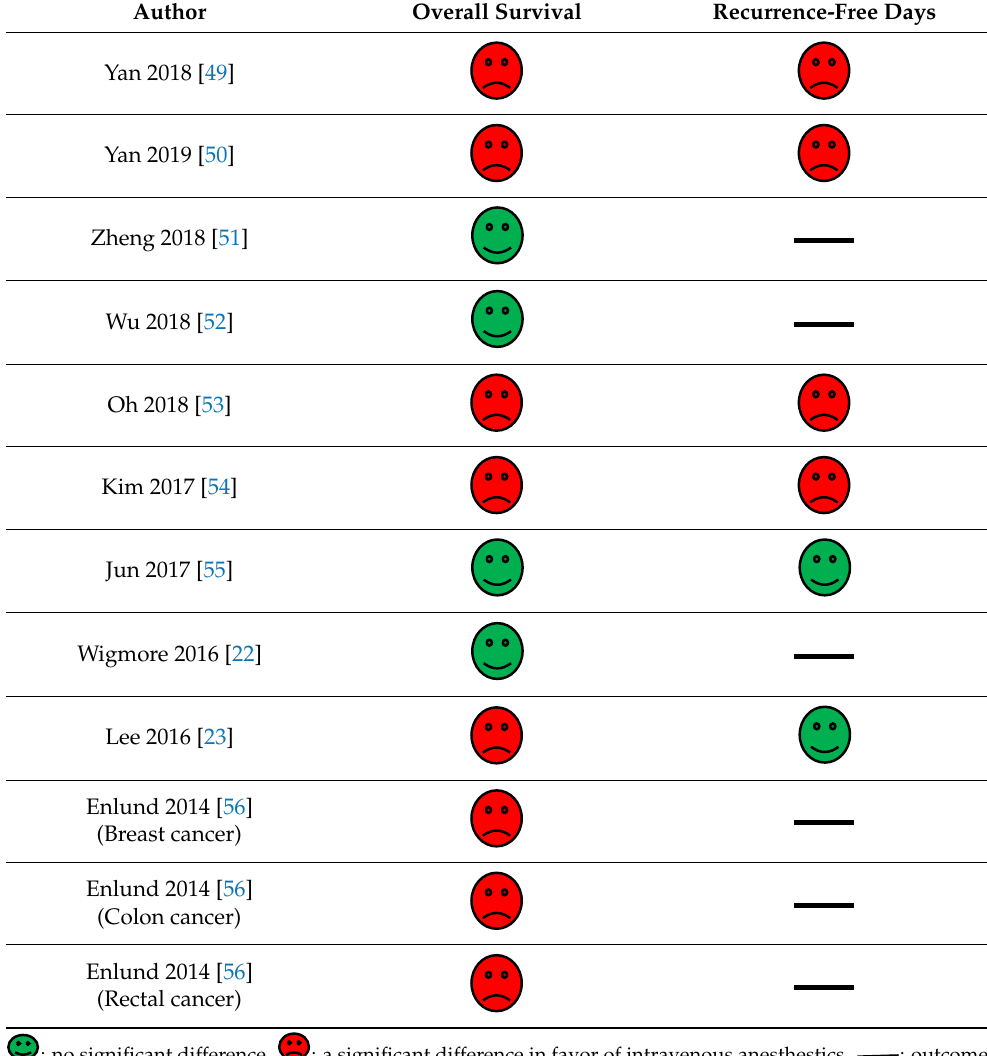
Table 1. Studies investigating the effect of intravenous anesthetics versus inhalation anesthetics on overall survival and cancer-free survival.